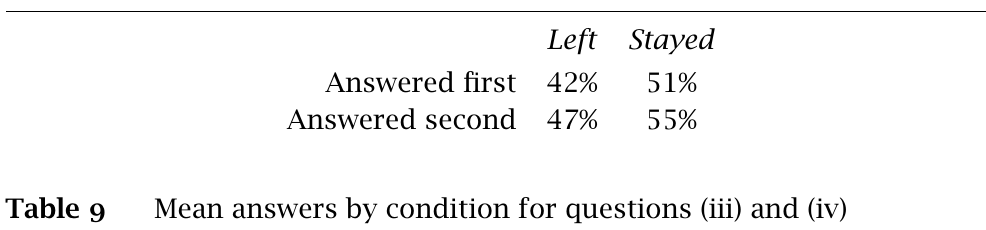
Table 9 Mean answers by condition for questions (iii) and (iv)